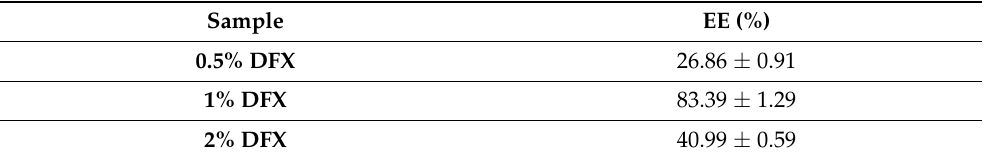
Table 3. EE (%) of F 1 C 1 .12 films at varying concentrations of DFX.